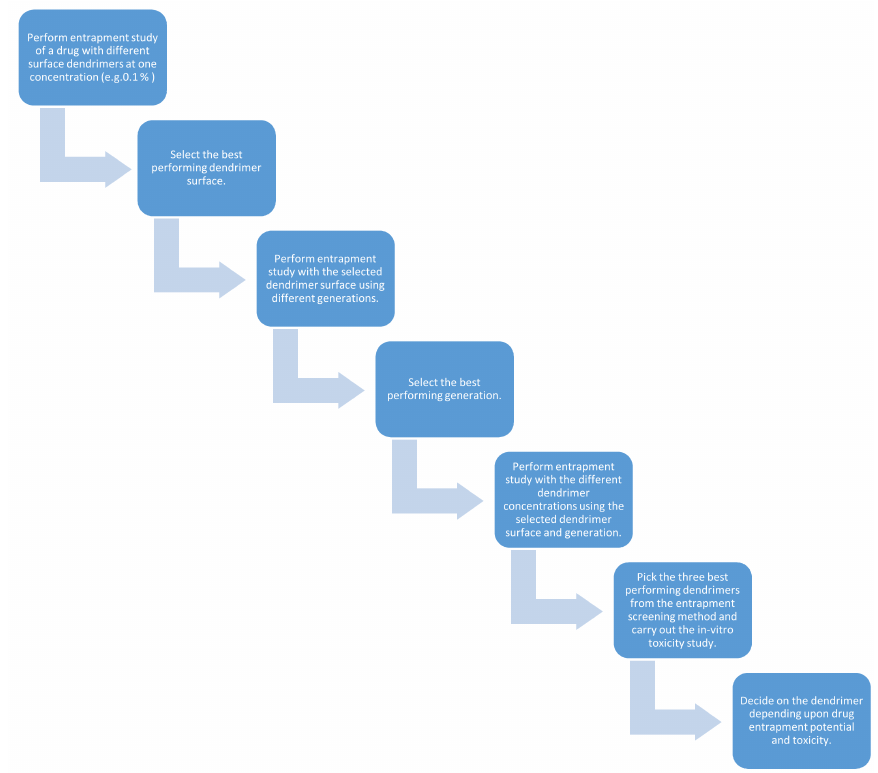
Scheme 1. Strategy to select dendrimers for drug